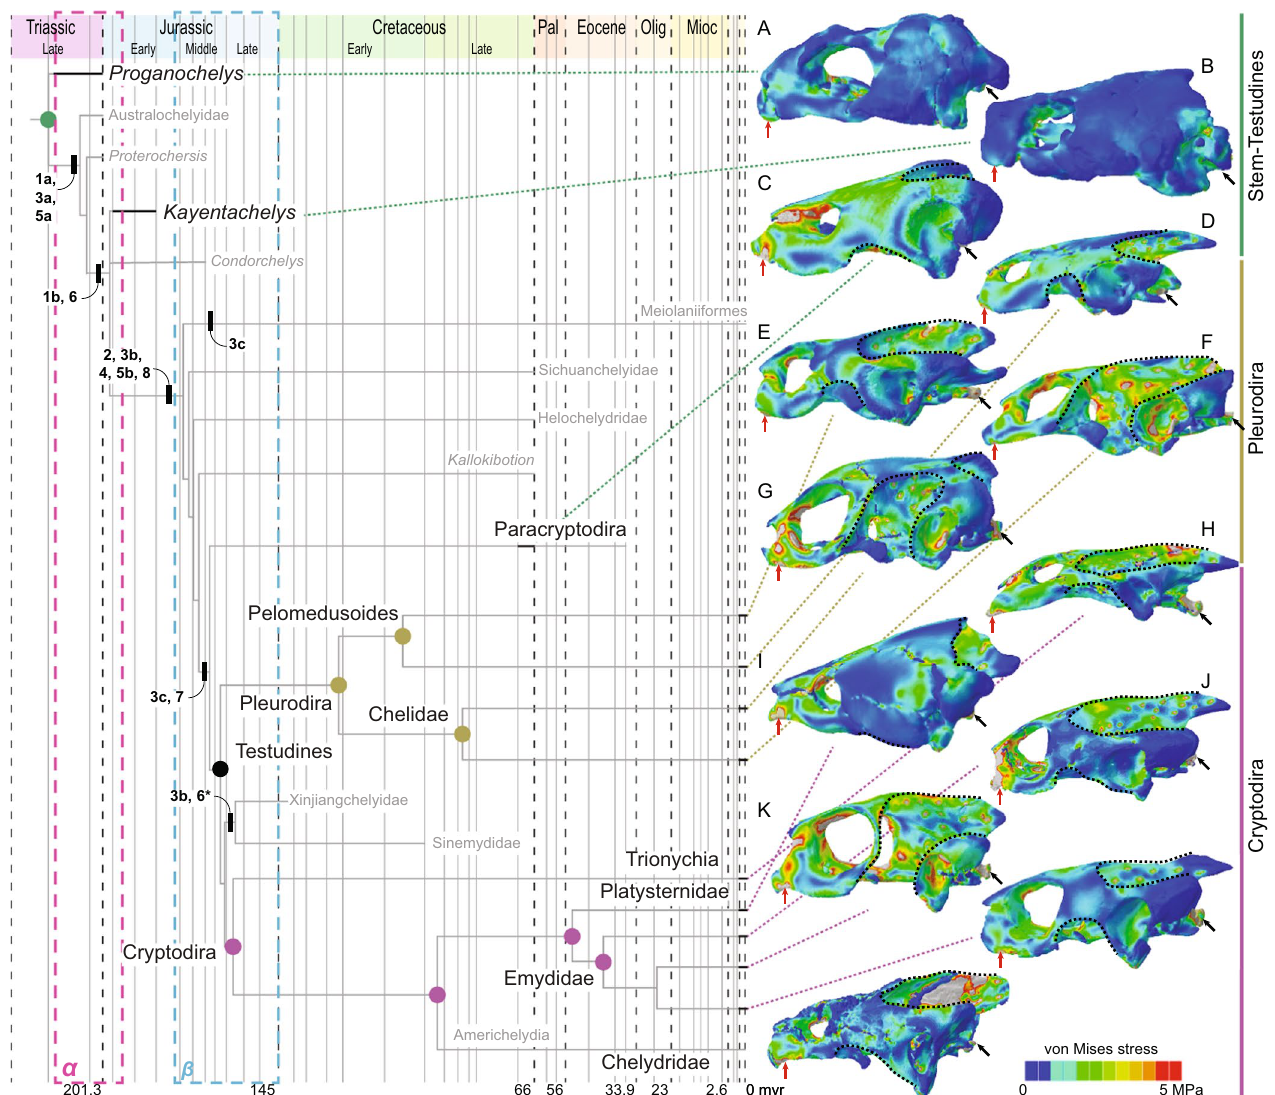
Figure 1. Stress plots resulting from biomechanical analysis of turtles simulated for bilateral biting. ( A–M ), von Mises stress contour plots on a time-calibrated phylogeny (modified from Joyce et al . 27 ). ( A ), † Proganochelys quenstedtii , ( B ), † Kayentachelys aprix , ( C ), † Eubaena cephalica , ( D ), Podocnemis expansa , ( E ), Pelomedusa subrufa , ( F ), Chelodina oblonga , ( G ), Emydura subglobosa , ( H ), Pelodiscus sinensis , ( I ), Platysternon megacephalum , ( J ), Graptemys geographica , ( K ), Terrapene carolina , ( L ), Emys orbicularis , ( M ), Chelydra serpentina . Contour plots are scaled to the same size and 5 MPa peak stress. Dotted curves represent the margins of the emarginations. The purple “ α ” and the blue “ β ” rectangles represent the first and second proposed selective regimes described below and on Fig. 5. Caption: 1a, enlarged otic chamber, but shallow tympanic cavity; 1b, enlarged otic chamber and deep tympanic cavity (largest); 2, adductor chamber extending posterior to otic chamber; 3a, basipterygoid process sutured and facing ventrally (low possible kinesis); 3b, basipterygoid process sutured and facing laterally (lower possible kinesis); 3c, basipterygoid process absent (definitive akinesis); 4, secondary lateral braincase wall; 5a, reduced interpterygoid vacuities; 5b, closed interpterygoid vacuities; 6, reduced foramen palatinum posterius; 7, reduced temporal roof by emarginations; 8, trochlear process; * ,